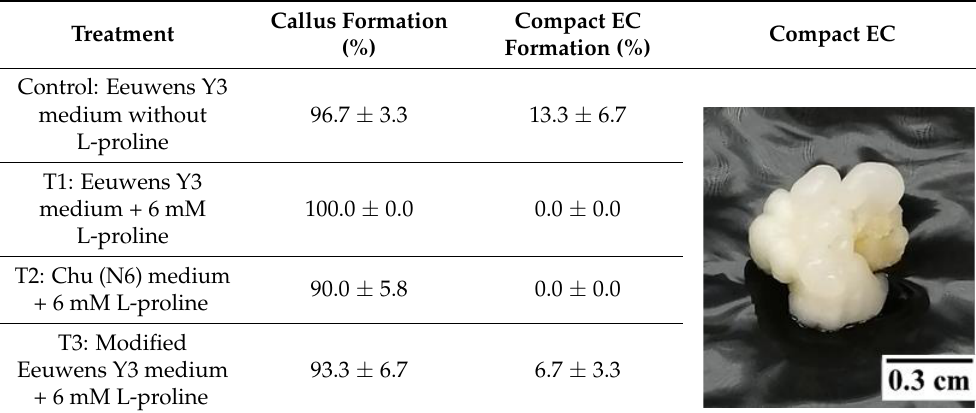
Table 2. The effect of different treatments on the percentage of callus and compact embryogenic callus (EC) formed. Callus Formation Treatment